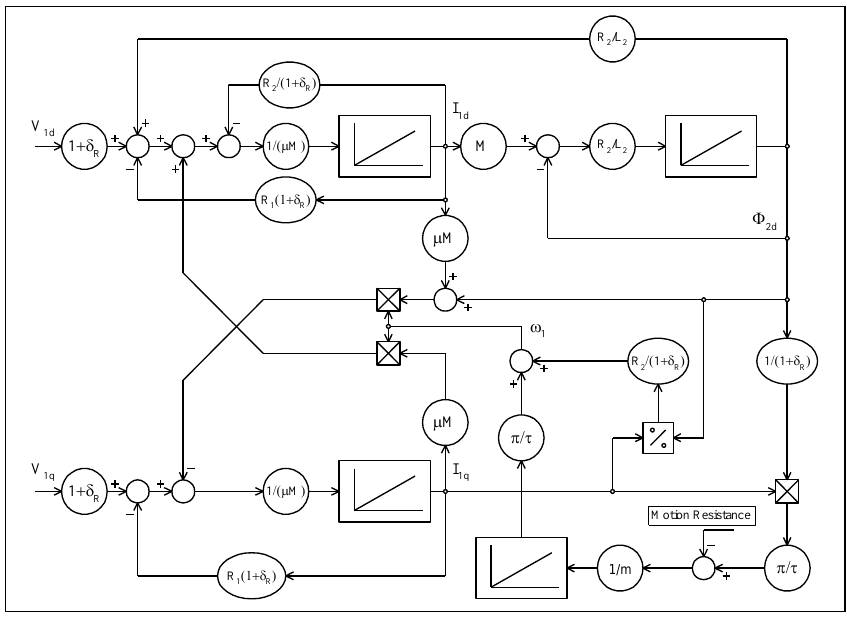
Figure 9. Rotor flux-oriented control LIM model [29,30].